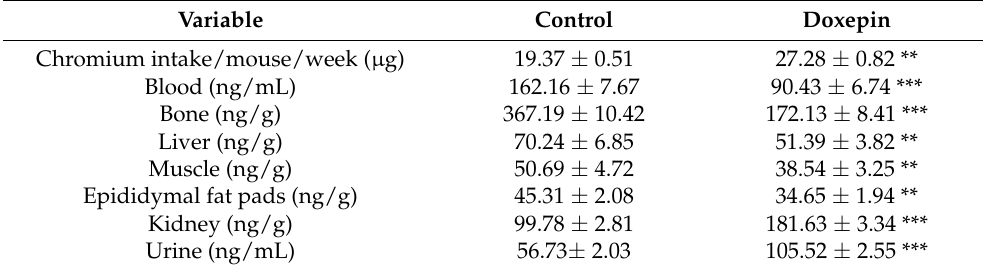
Table 2. Tissue and organ Cr levels in control and doxepin-treated obese mice over 56 treatment